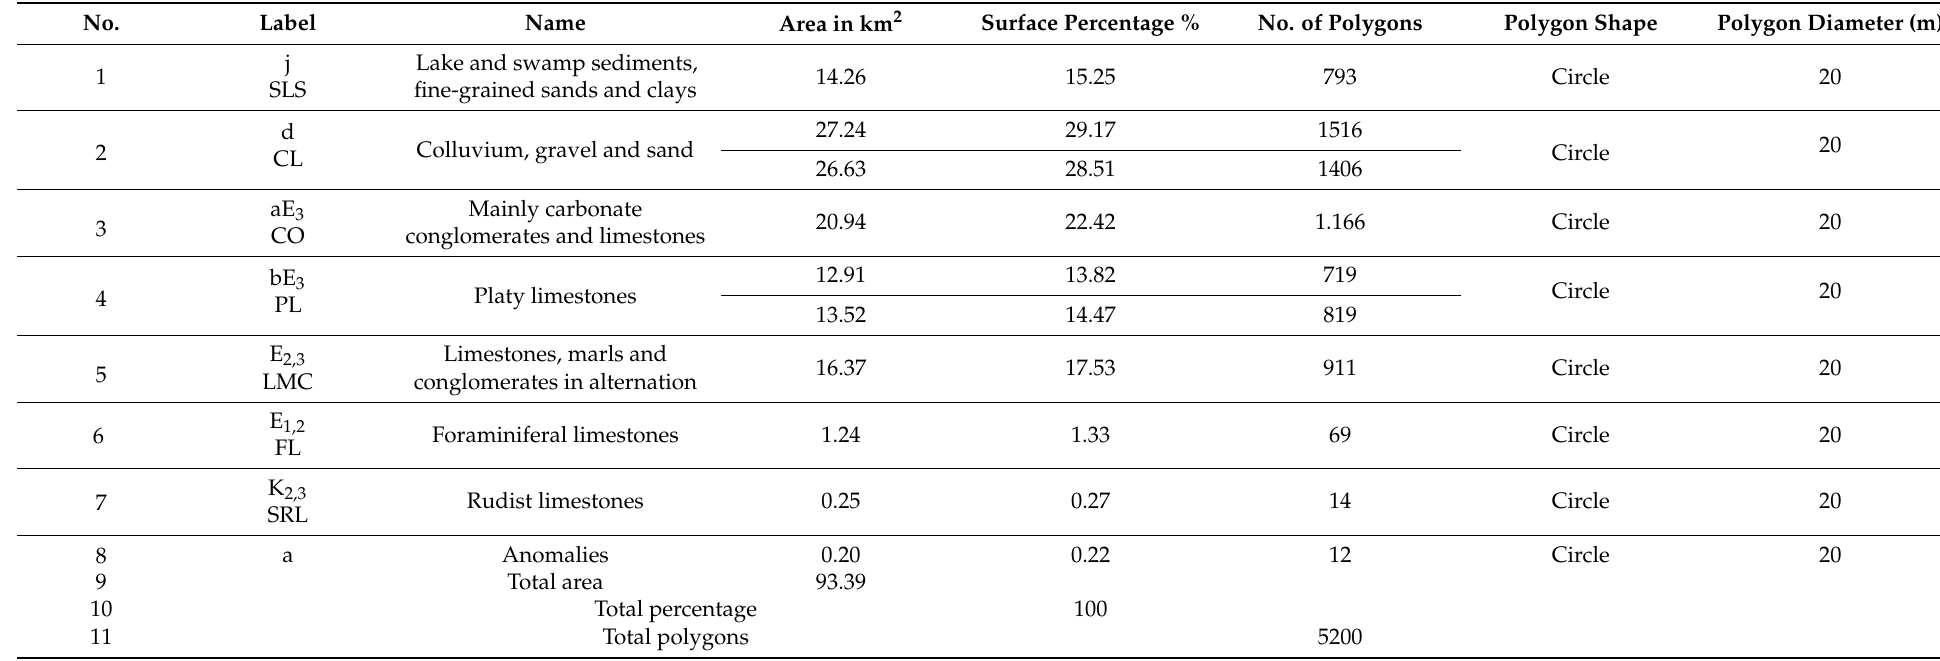
Table 1. RF input polygon data for each lithological